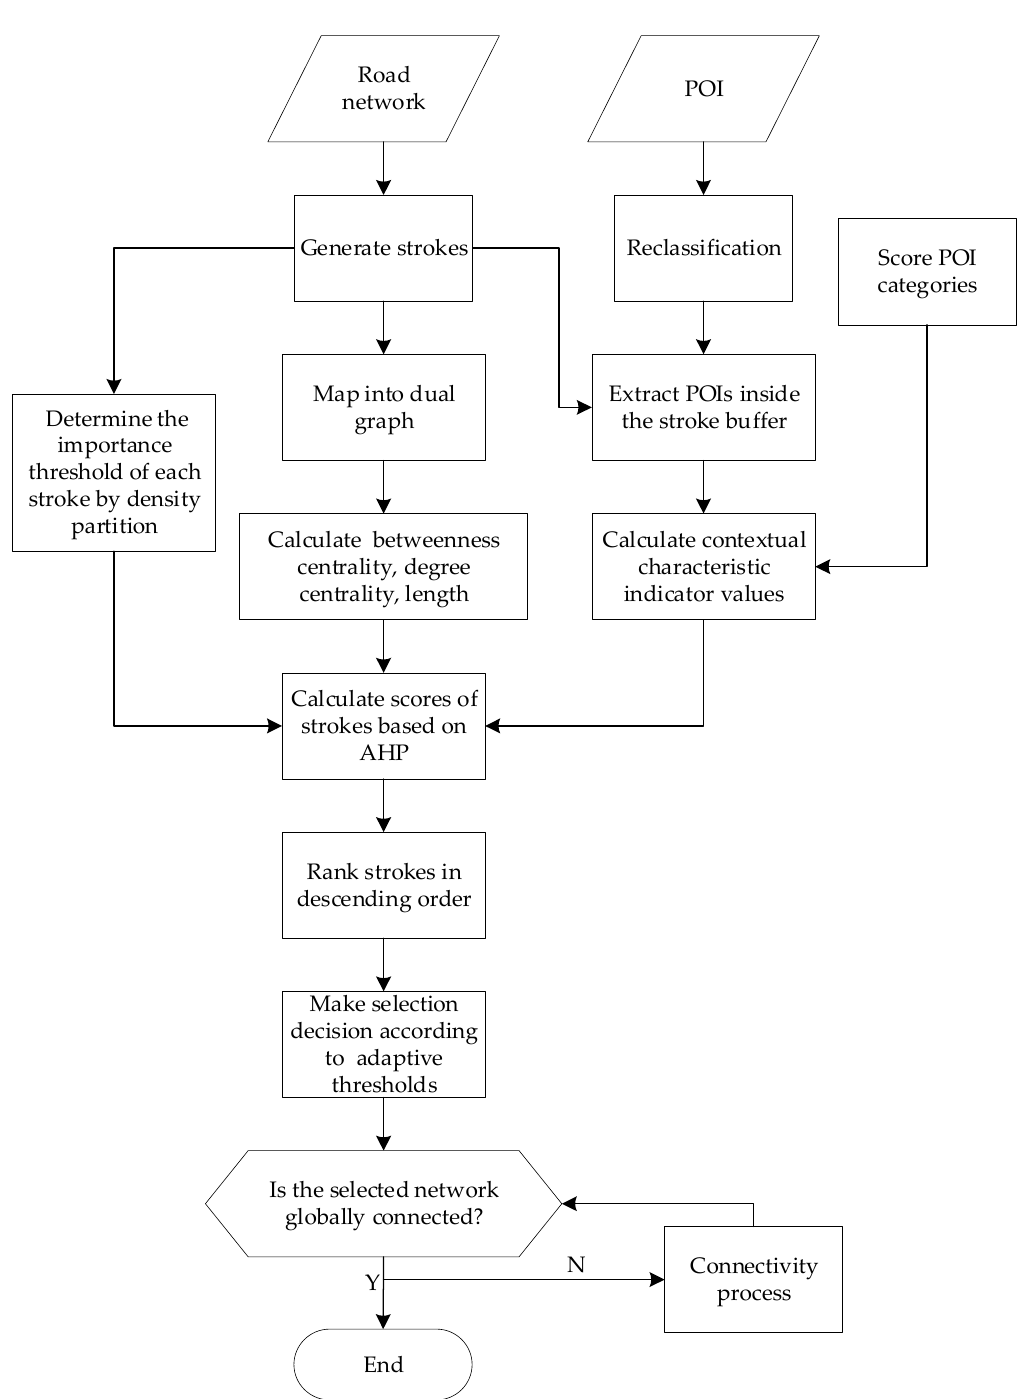
Figure 5. Process of road selection.